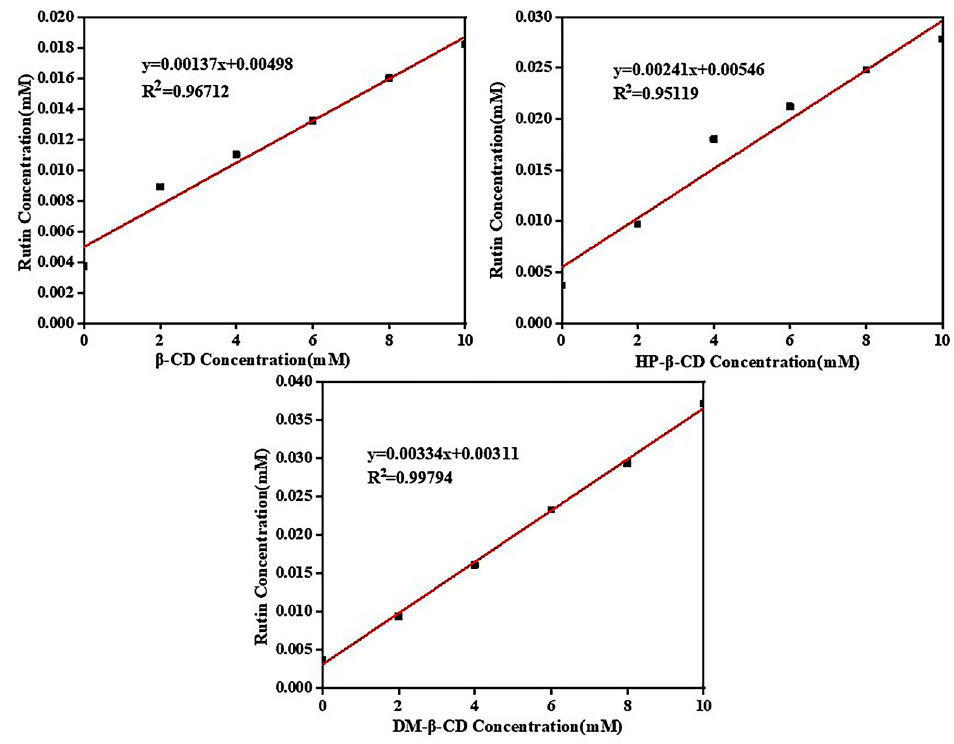
Figure 7. Phase solubility diagram of three cyclodextrins and rutin.